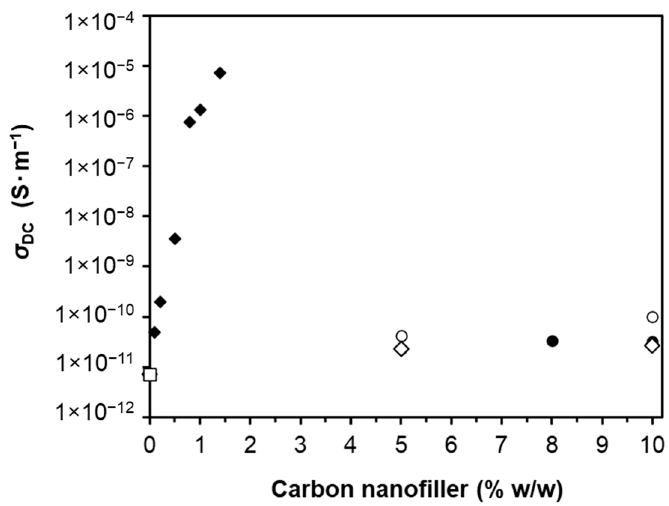
Figure 11. DC electrical conductivity, σ DC , at room temperature as a function of carbon nanofiller concentration ( υ —MWCNT; —GO; ● —rGO; ◇ —Gr; □ —undoped) in the LS-based PU compo- site.